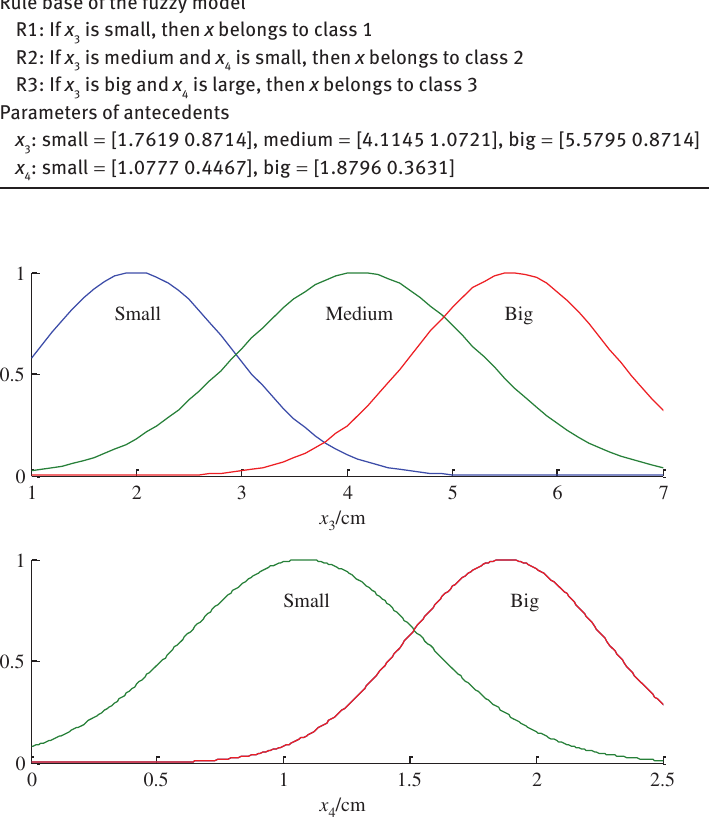
Table 4: The Fuzzy Model Obtained by the NSFOA Algorithm. Rule base of the fuzzy model